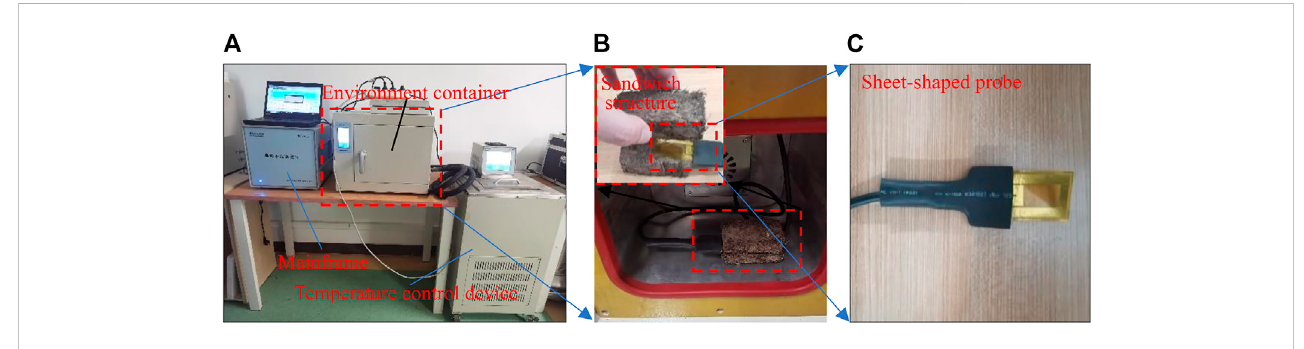
TC3100 thermal conductivity